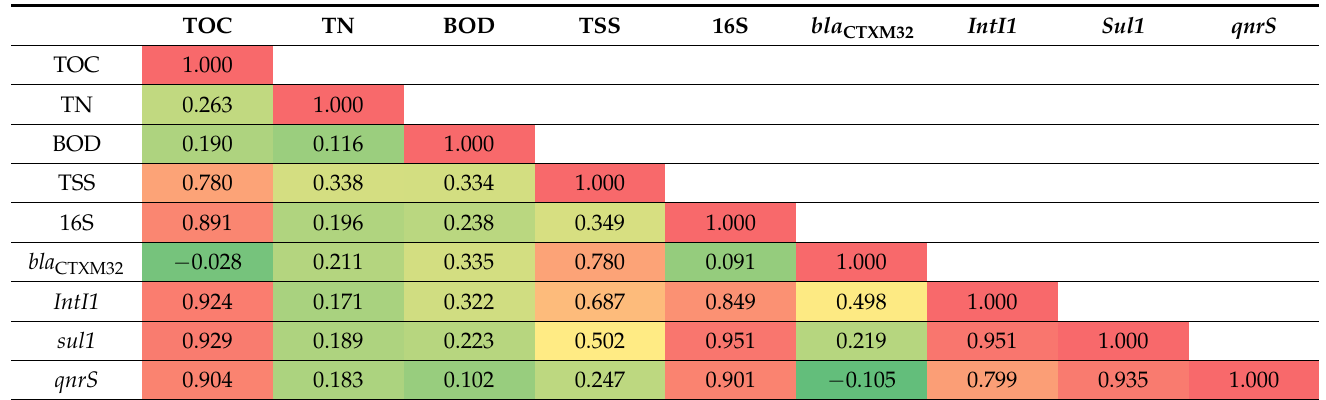
Table 3. Pearson’s correlation analysis of raw and treated water quality parameters and ARG in the CWs.